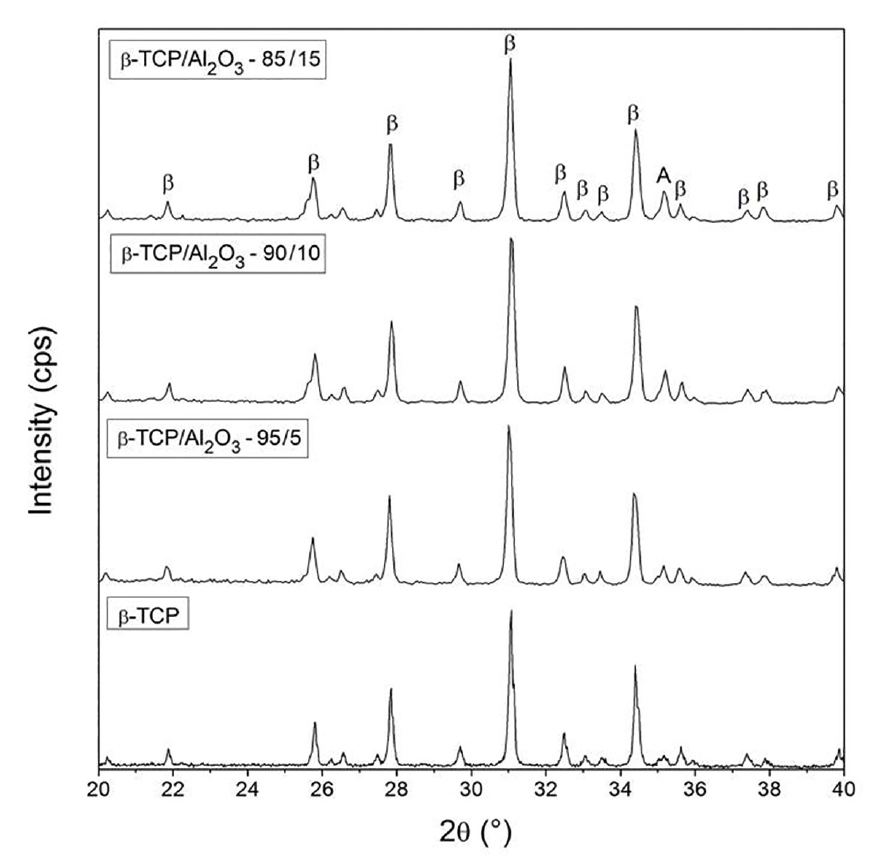
O scaffolds. β=β-TCP; A=Al 2 3